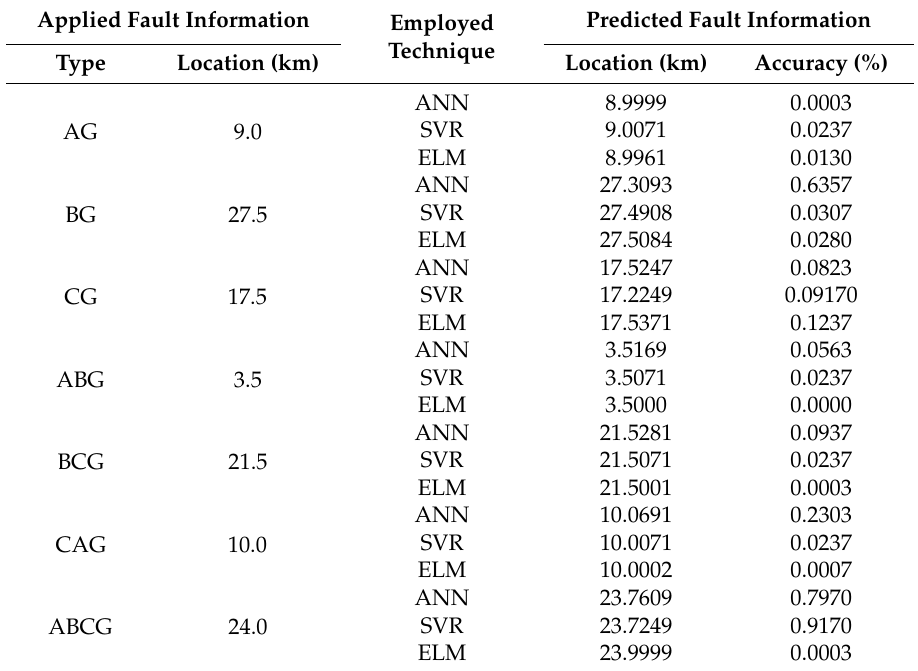
Table 9. Fault location results obtained employing the ST based machine learning tools, for the four-node test distribution